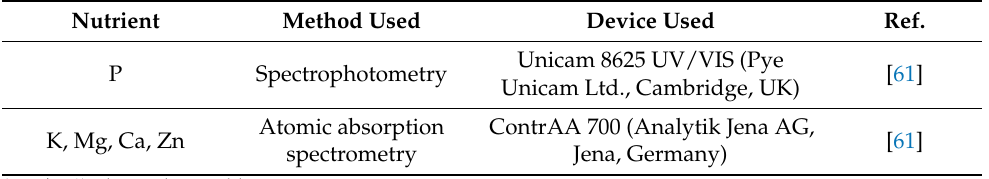
Table 8. The methods for the determination of nutrients in pea seed. Nutrient Method Used Device Used Ref. Unicam 8625 UV/VIS (Pye P Spectrophotometry [61] Unicam Ltd., Cambridge, UK) Atomic absorption ContrAA 700 (Analytik Jena AG, K, Mg, Ca, Zn spectrometry Jena, Germany)